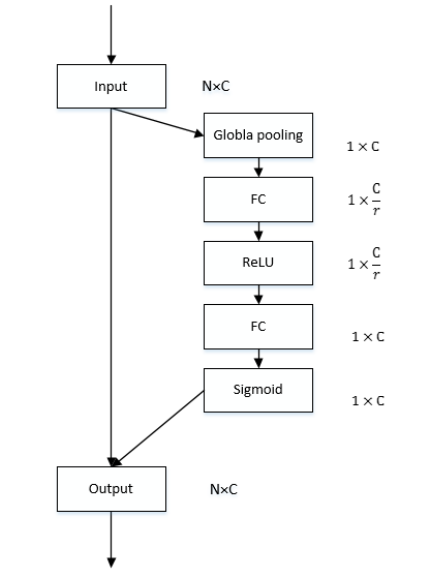
Fig. 2. The schema of the SE